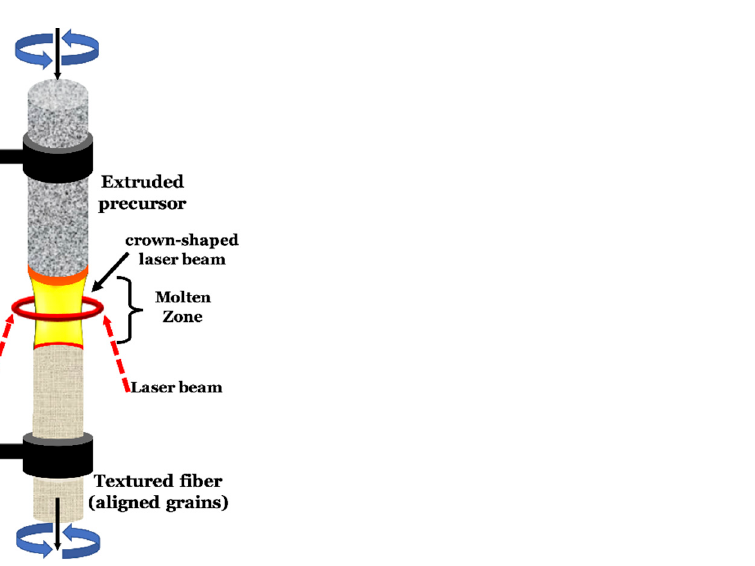
Figure 2. Schematic drawing of Electrically Assisted Laser Floating Zone (EALFZ) at the processing area, highlighting the D.C. power supply unit, Carrasco et al., 2004 [29].